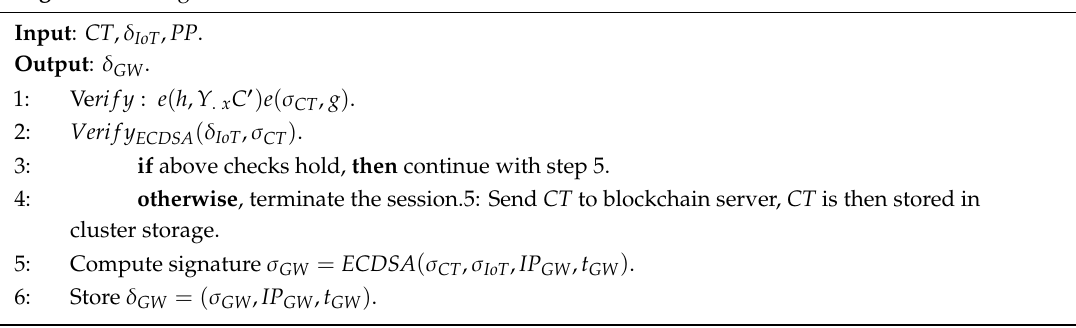
Algorithm 8: Log Verification.